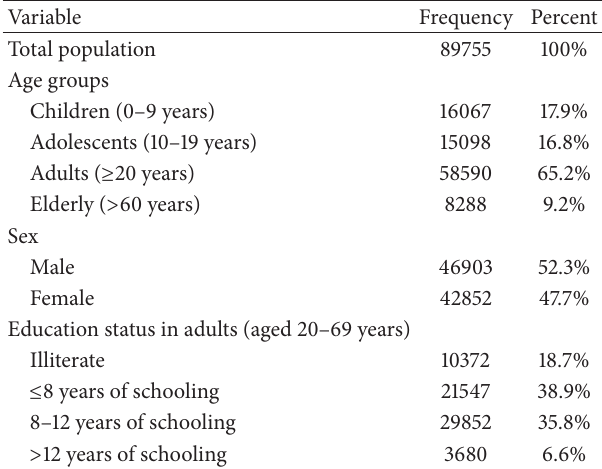
Table 1: Age and sex distribution and education status of the study